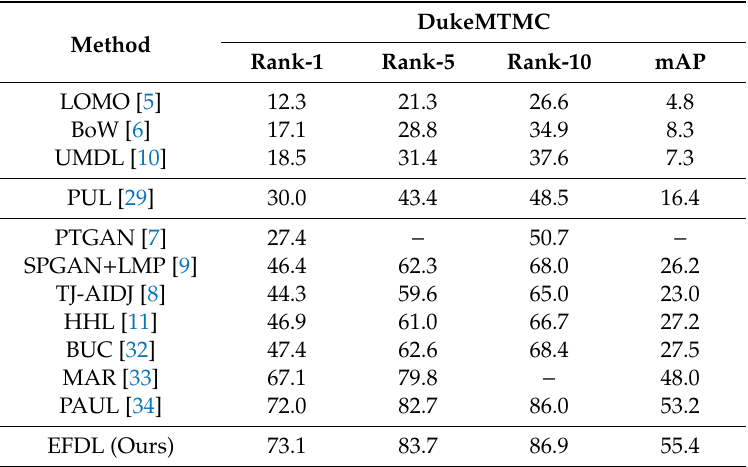
Table 2. Comparison with existing methods on